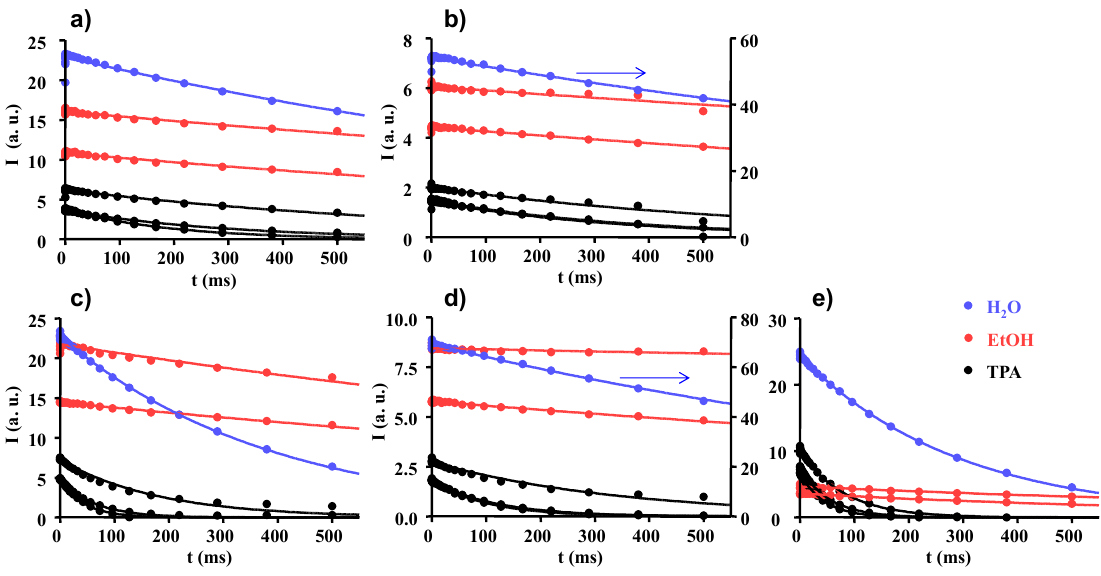
Figure 6. Proton spin-lattice relaxation in the rotating frame ( T 1 ρ H ) curves for the different resonances of TPA, ethanol and water in samples without Si content ( a ) S0; and ( b ) SD0; and with Si content ( c ) S; ( d ) SD; and ( e ) SH. The solid lines represent least-square fits of the experimental data using monoexponential decay function ( I = I ∞ exp( − t / T 1 ρ H )).